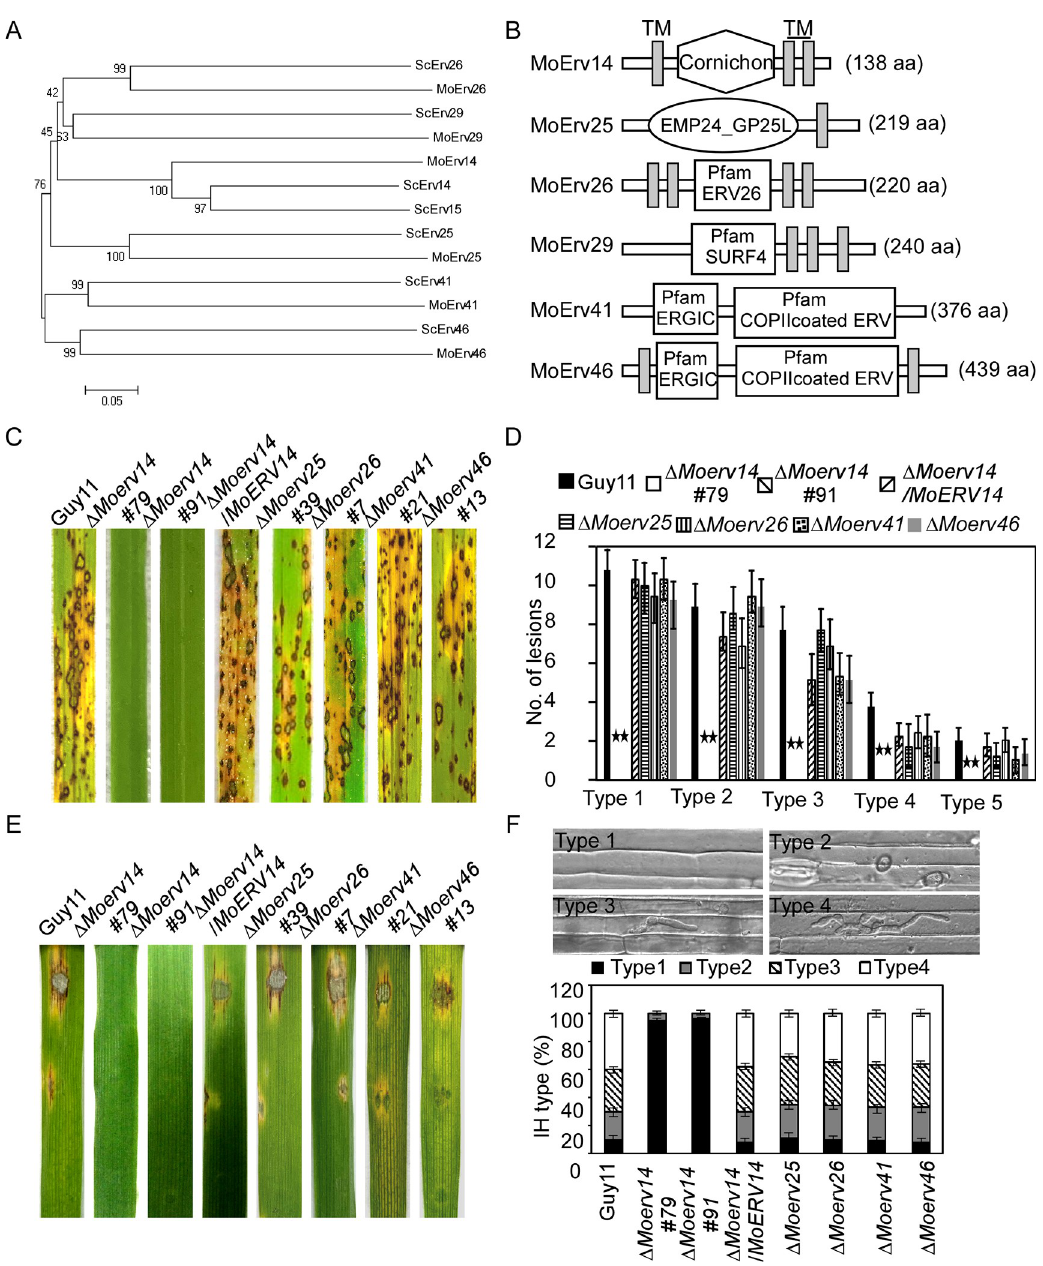
Fig 1. Prediction, phylogenetic analysis, and virulence of ERV (ER-derived vesicles) proteins in M . oryzae . (A) Phylogenetic trees of ERV proteins from several organisms were constructed using the CLUSTAL_W, and MEGA 5.1 programs by the neighbor-joining method with 1000 bootstrap replicates. (B) Schematic representation of ERV proteins in M . oryzae . (C) Two- week-old rice seedlings ( Oryza sativa cv. CO-39) were sprayed with tested with a conidial suspension of different mutants (5 × 10 4 conidia/ml). The diseased leaves were harvested and photographed 7 days after inoculation. Three independent experiments were performed. (D) Quantification of lesion types (per 1.5 cm 2 ) on susceptible rice leaves. 0, no lesion; 1, dark-brown pinpoint lesions; 2, 1.5 mm brown spots; 3, 2–3 mm lesions with brown margins; 4, eyespot lesions longer than 3 mm; 5, coalesced lesions infecting 50% or more of the leaf maximum size. Asterisks represent significant differences ( p < 0.01). (E) Separated barley leaves were dropped with serial dilution (1 × 10 5 , 1 × 10 4 , 1 × 10 3 conidia /ml) of conidial suspensions, and diseased leaves were photographed 5 days after inoculation. (F) Conidial suspensions (1 × 10 5 spores/ml) of three different strains were injected into separate rice sheaths, and the infection severity was observed at 24 h post-inoculation (hpi). Percentages of different types of infectious hyphae in rice cells were counted at 24 hpi. Sample size (n) = 50. Error bars represent the standard deviations. Type 1, no infection structures; Type 2, only with a appressorium; Type 3, only with a single invasive hypha (IH); Type 4, with 1–3 branches but restricted in one cell.